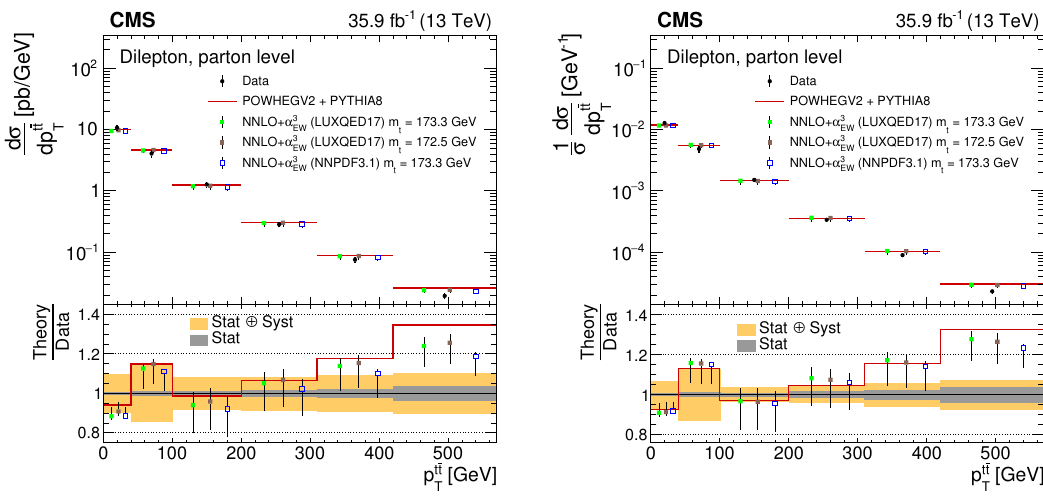
Figure 25 . The di(cid:11)erential tt production cross sections at the parton level in the full phase space as a function of p tt are shown for the data ((cid:12)lled circles), the theoretical predictions with beyond- T NLO precision (other points) and the prediction from powheg + pythia (solid line). The vertical lines on the (cid:12)lled circles and other points indicate the total uncertainty in the data and theoretical predictions, respectively. The left and right plots correspond to absolute and normalised measure- ments, respectively. The lower panel in each plot shows the ratios of the theoretical predictions to the data. The dark and light bands show the relative statistical and total uncertainties in the data, respectively.